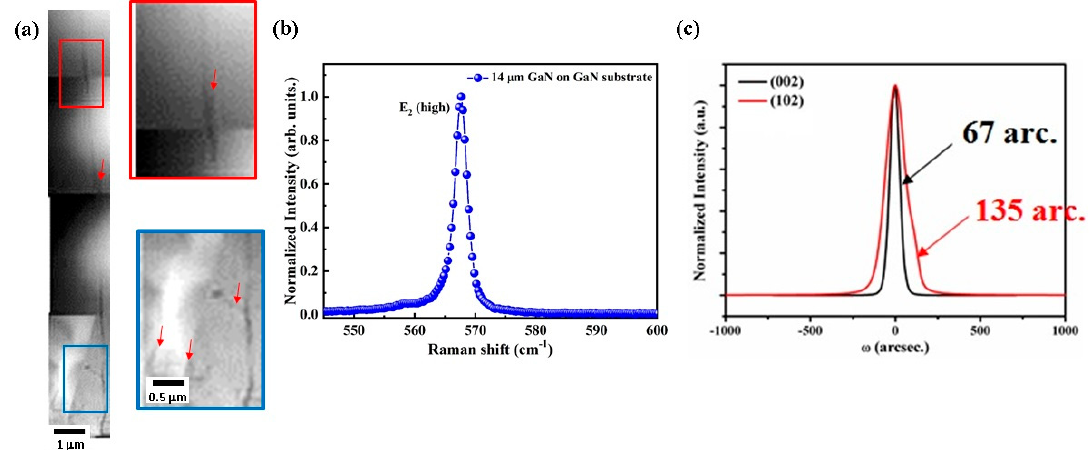
Figure 3. ( a ) TEM image of 15- µ m-thick GaN epilayers grown on the FS-GaN substrate. The red arrows indicate the TDs. The di ff raction condition is g = 0002. ( b ) Raman spectrum of a thick GaN epitaxial layer. ( c ) XRD rocking curves of a thick GaN epitaxial layer, and the (002) and (102) planes are shown.